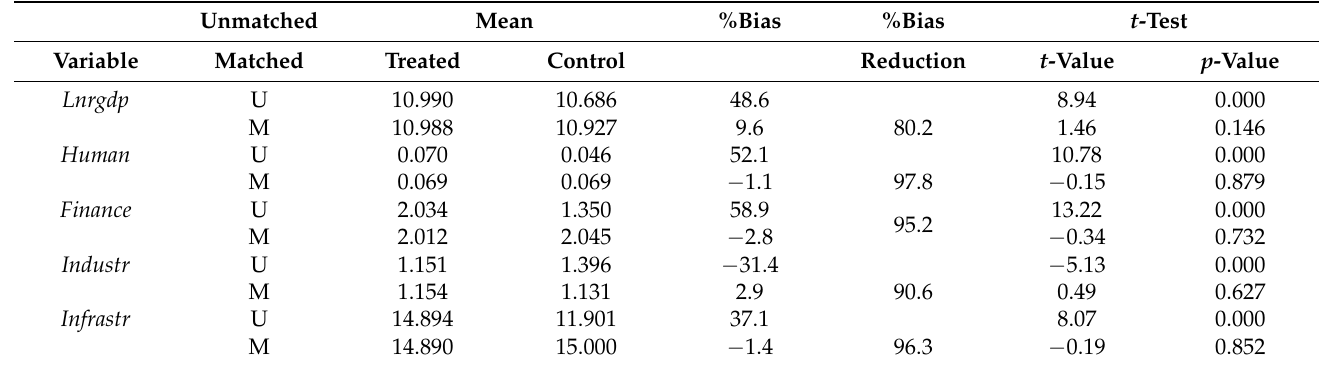
Table 3. Balancing test results.